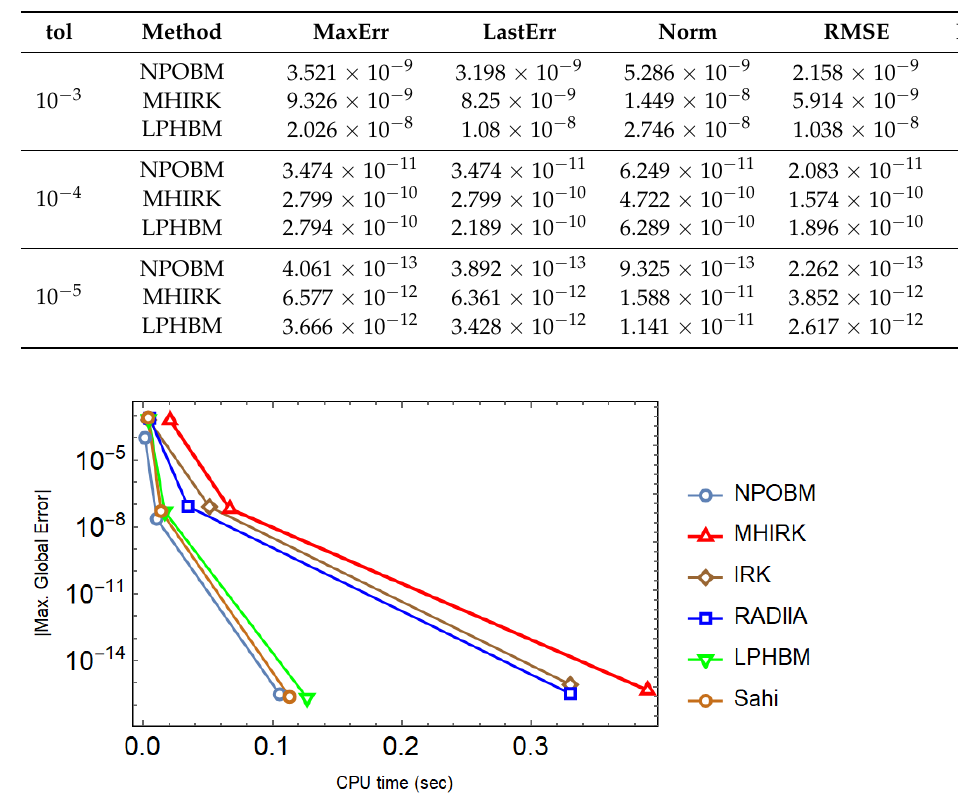
Figure 4. Efficiency curves for the system in Problem 1 to observe the behavior of absolute maximum global errors versus the CPU time (sec) with a logarithmic scale on y -axis.